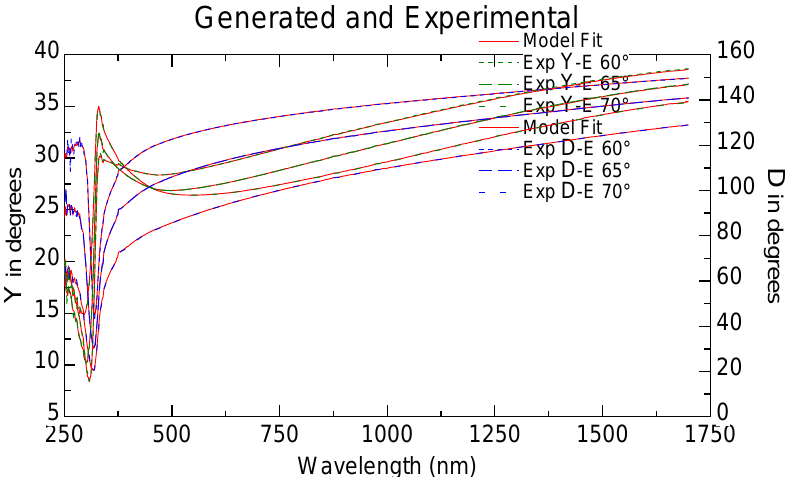
Figure 5. Ellipsometric angles Y and D, experimental and fitted for the sample SO-Ag9.